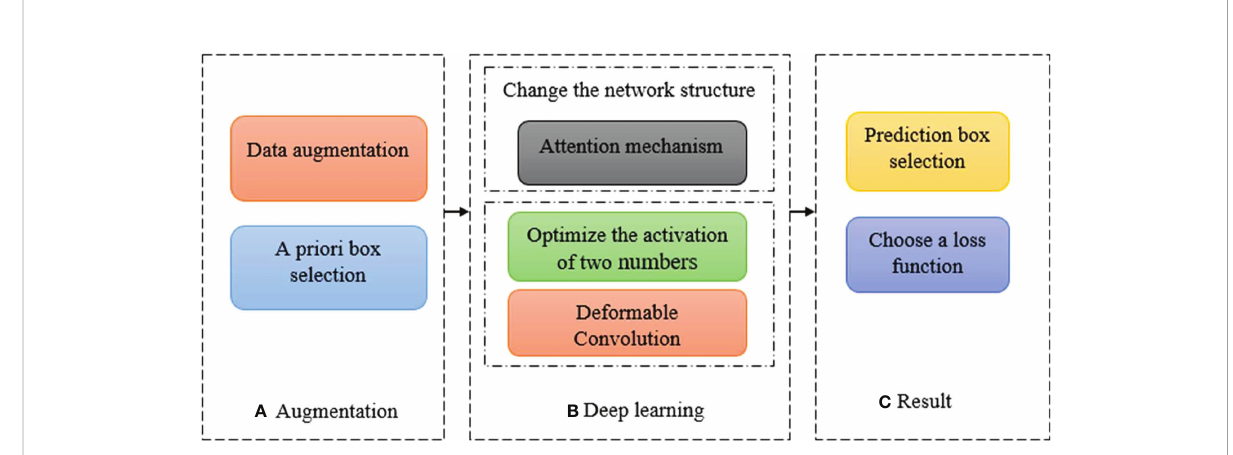
FIGURE 4 The corresponding improvement scheme of algorithm detection fl ow (A) Augmentation (B) Deep Learning (C)